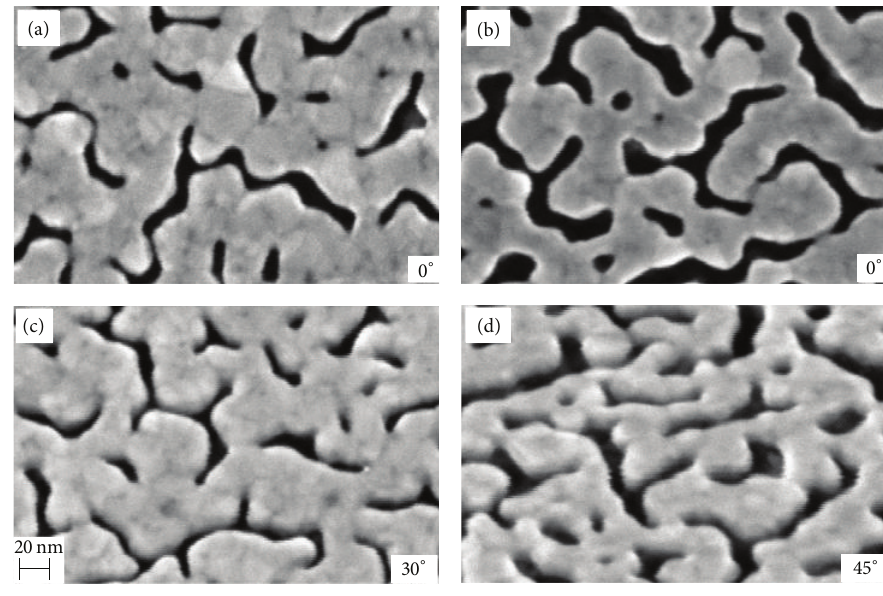
Figure 6: Plain and tilted SEM images of 16nm thick Au nanostructures with a 1nm thick sublayer of Ti: the structures (a) and (c) are created on the template of Figure 5(b) and the structures (b) and (d) on the template of Figure 5(c). Here 𝛼 = 0. The view angles are